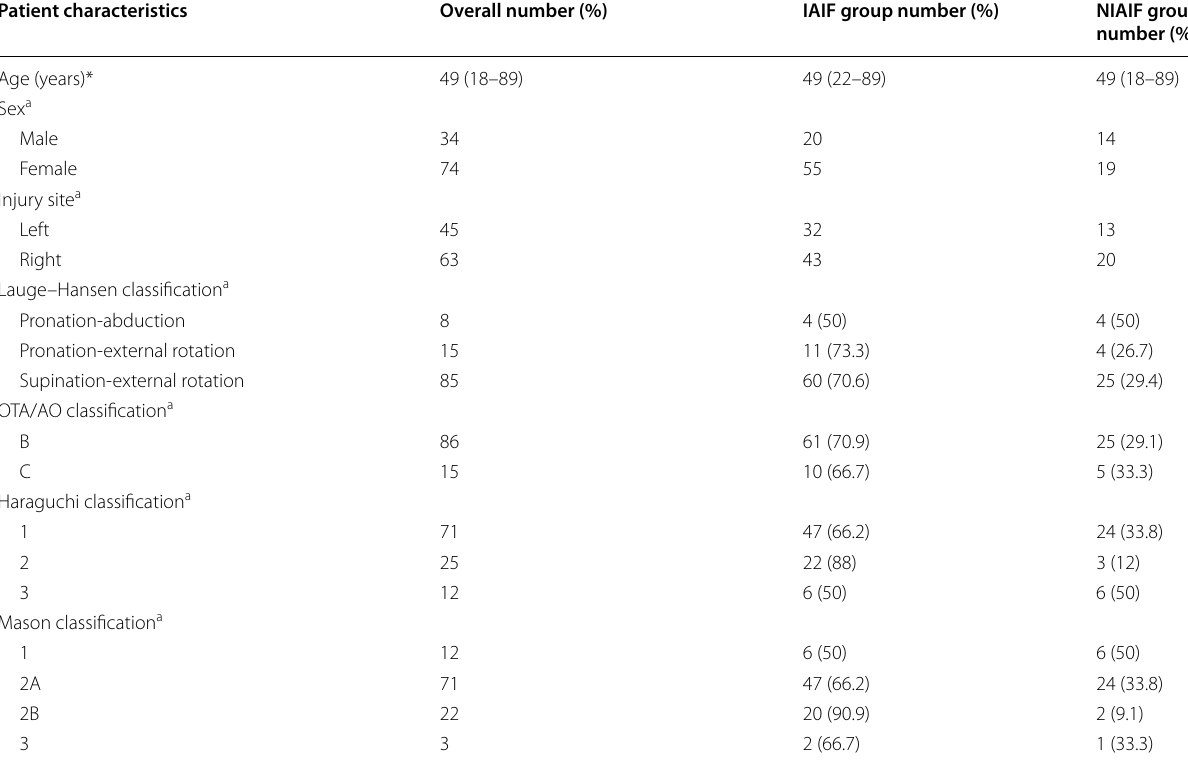
Table 1 Patient characteristics ( N